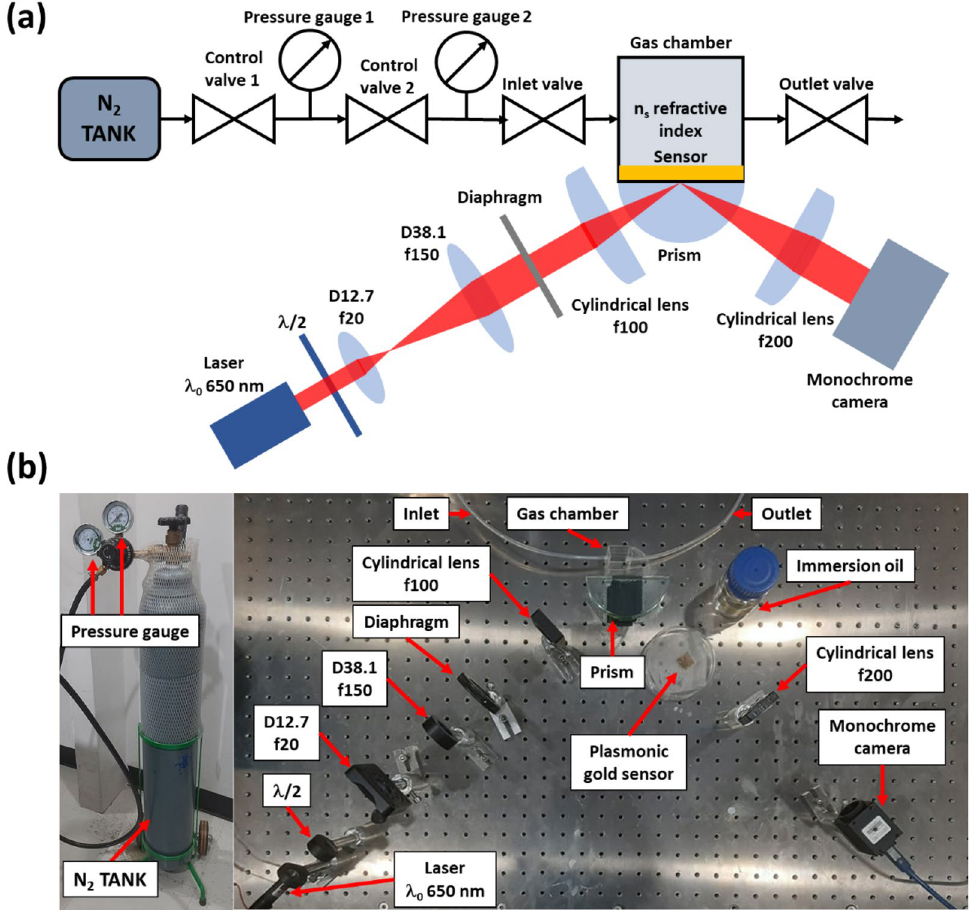
Figure 1. Kretschmann-based SPR experiment equipped with an acrylic gas chamber and nitrogen gas control unit ( a ) schematic diagram of the SPR system, ( b ) photo the experimental